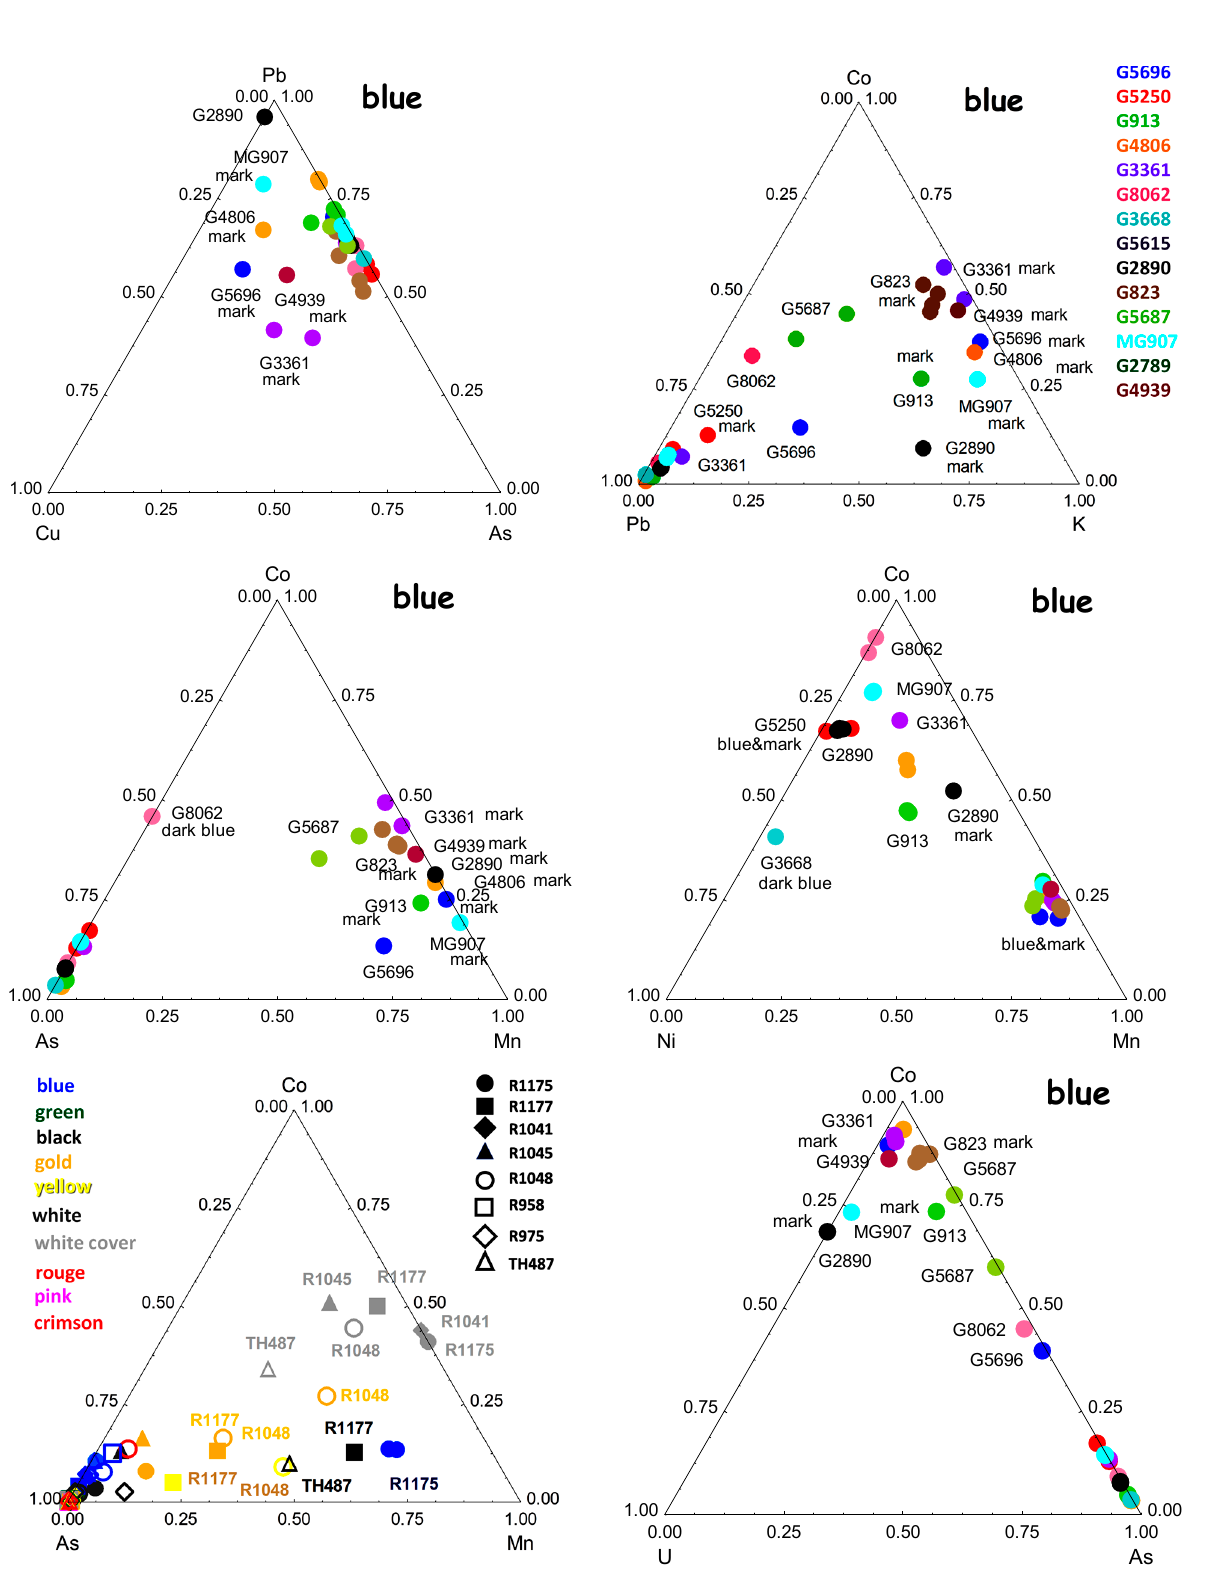
18 Figure 6. Comparison of signal of flux elements (Pb, Ca, K) of enamel matrices and associated el- ements (Sr, R, Y, As) (Coll. Louvre). See legend to Figure 5 for explanation of symbols. 4.4. Comparison of Coloring Agents Figure 7 compares the distributions of the signals relating to the color blue, i.e., co- balt and the associated elements, arsenic, manganese and nickel. The use of blue ingre-